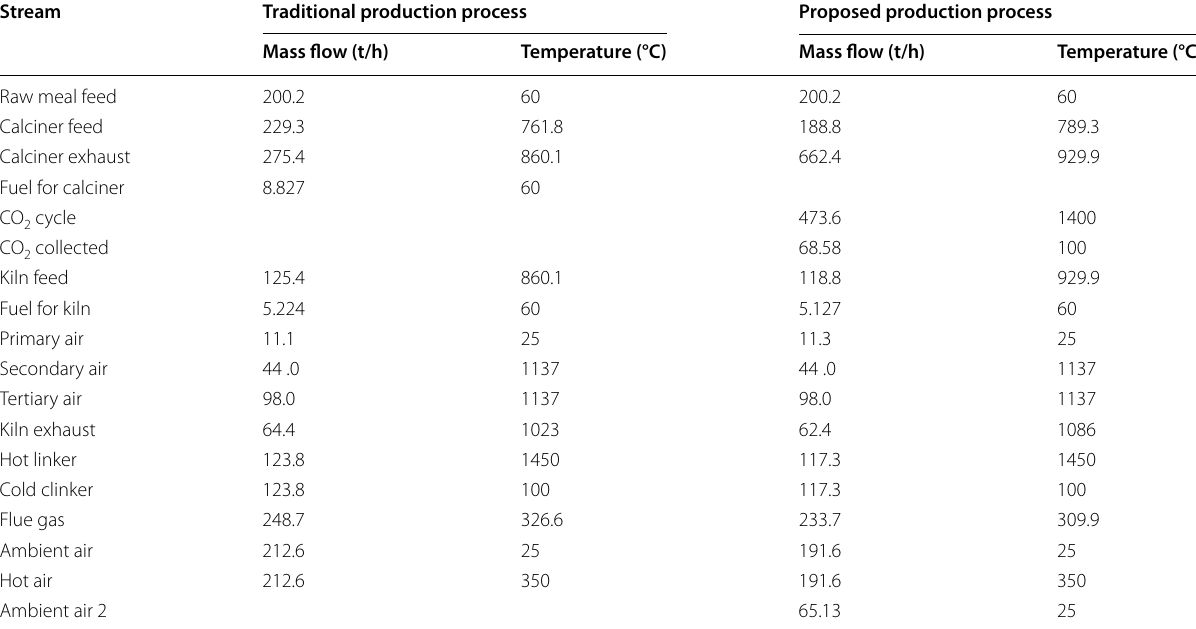
Table 2 Mass flow rate and temperature of the streams in the cement production processes